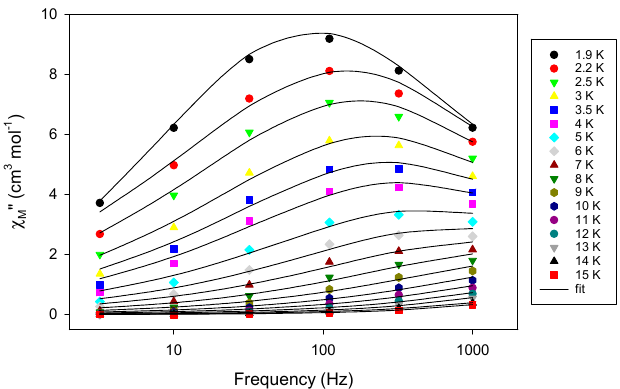
Figure 8. Frequency dependence of the out-of-phase ( χ M (cid:48)(cid:48) ) ac magnetic susceptibility at 200 Oe dc field for 1 · 3MeOH · CH 2 Cl 2 , measured in a 3.0 G ac field at the temperature range 1.9–15 K. Solid lines represent fits to the data, as described in the main